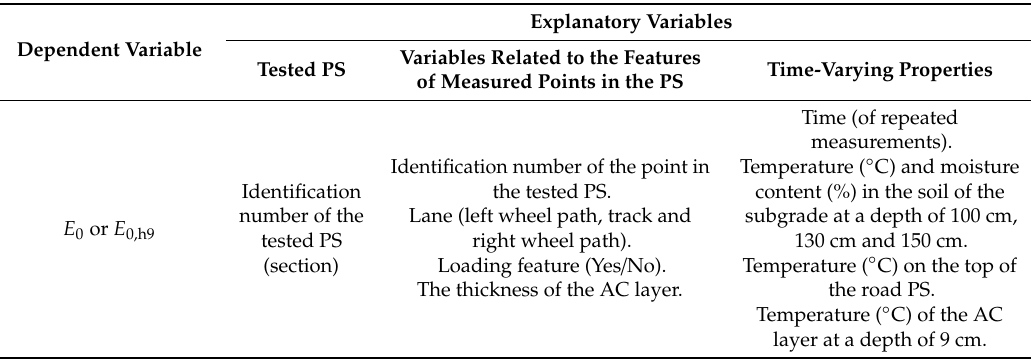
Table 4. Types of variables in the